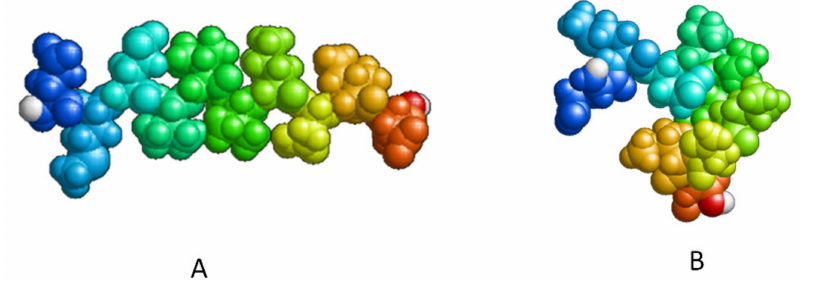
Figure 4. Typical force reaction of P2 peptide (red) and a membrane (black) when the peptide is pulled by the atom at a constant rate of 0.1 Å/ps. Snapshots of this process are presented at different time points: 0, 200, 400, 600, 800, and 1000 ps.